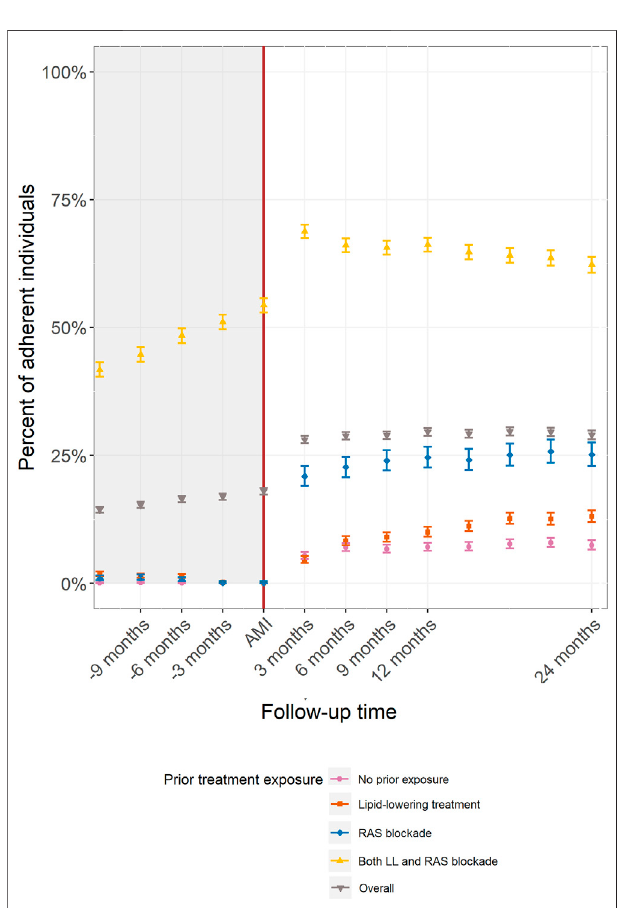
FIGURE 2 | Adherence to both lipid-lowering and RAS blockade treatments by pre-AMI treatment exposure.